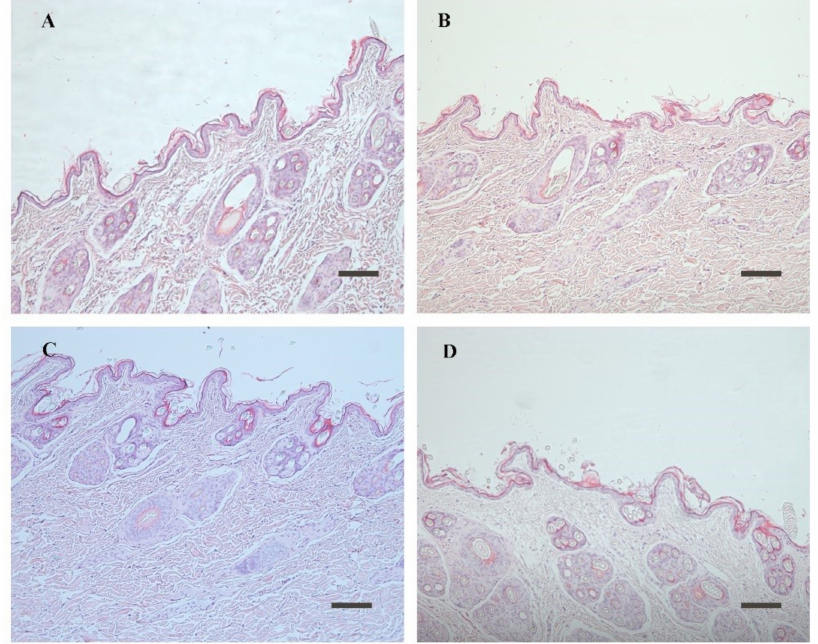
Figure 6. Histological micrograph of rat skin after treatment with: ( A ) BE; ( B ) ME; ( C ) Lamisil ® cream; and ( D ) PBS. (The upper layer in the picture represents SC. Scale bar: 200 µ